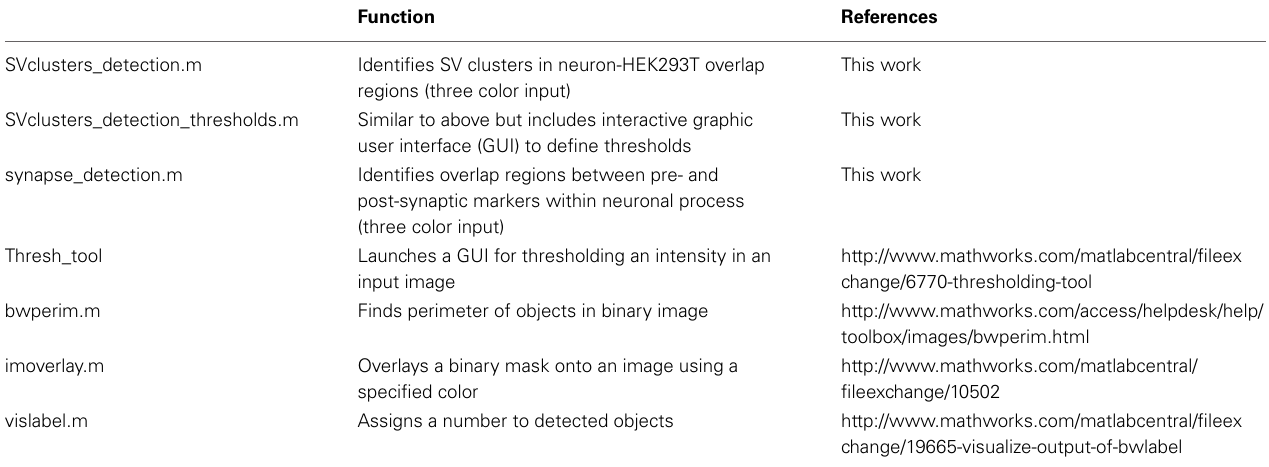
Table 3 | List of. m